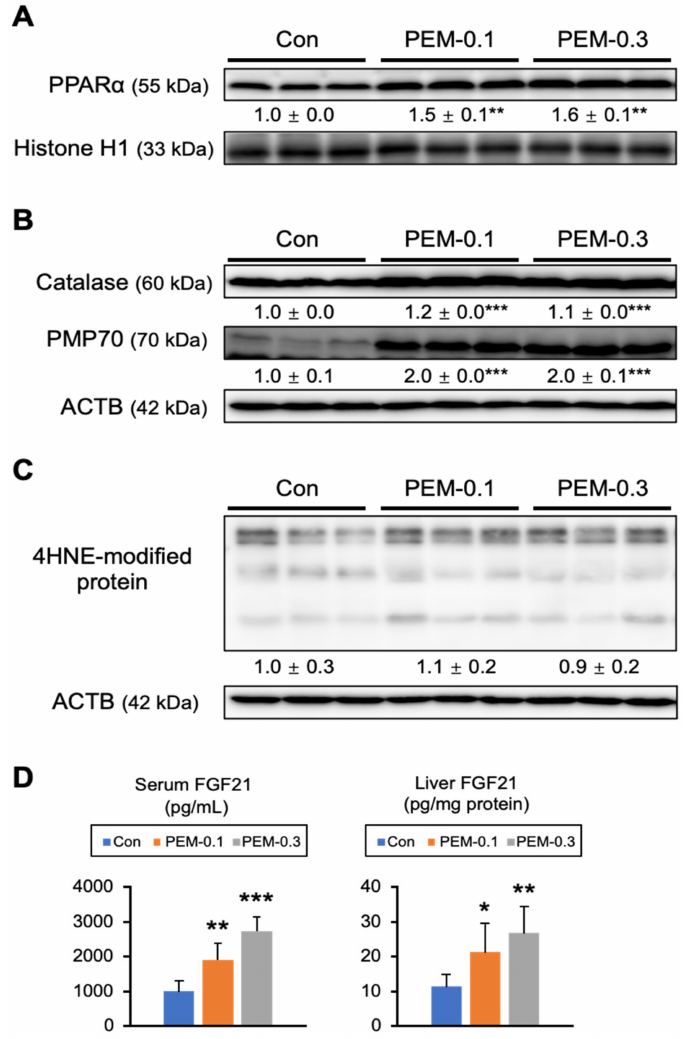
Figure 8. Clinically relevant dose of PEM activates hepatic PPAR α without enhancing oxidative stress. ( A ) Immunoblot analysis of PPAR α . Histone H1 was used as a loading control. ( B , C ) Immunoblot analysis of catalase, PMP70, and 4-HNE-modified protein. ACTB was used as a loading control. Band intensity was measured densitometrically, normalized to that of histone H1 or ACTB, and expressed as values relative to those of control mice. Results were obtained from two independent immunoblot experiments. ( D ) Serum FGF21 level and hepatic FGF21 content. Data are expressed as the mean ± SD. * p < 0.05, ** p < 0.01, and *** p < 0.001 vs. control group. Con, vehicle-treated mice; PEM-0.1, pemafibrate-treated mice at a clinically relevant dose (0.1 mg/kg/day); PEM-0.3, pemafibrate-treated mice at a relatively high dose (0.3